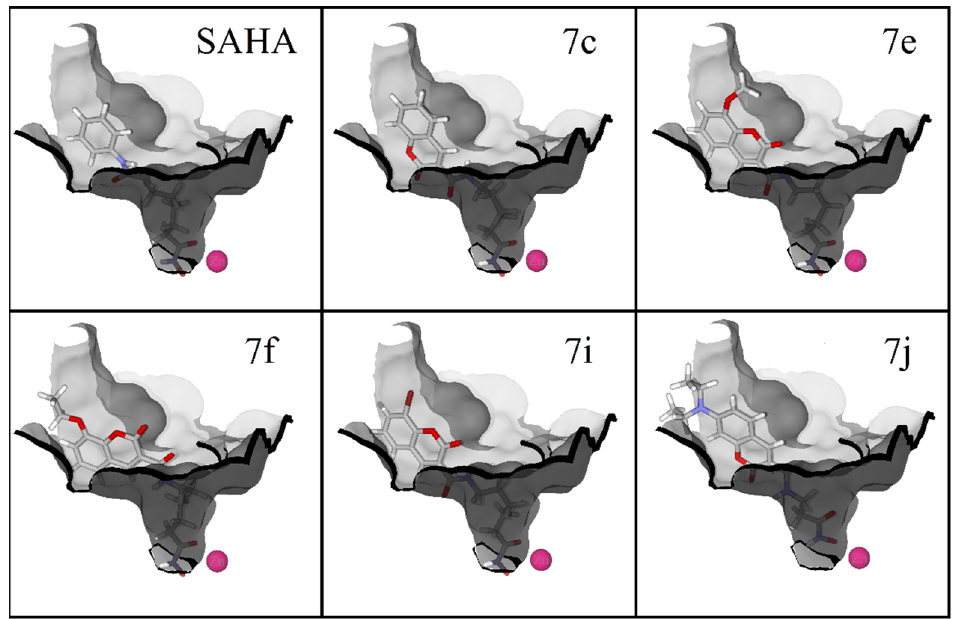
Figure 6. The binding modes for SAHA and compounds 7c , 7e , 7f , 7i and 7j at the active site of HDAC1, according to molecular docking calculations. The ligands are illustrated with a tube model. Oxygen atoms are depicted in red, the bromine atom in dark red, carbon atoms in gray, nitrogen atoms in purple and the zinc atom in pink.